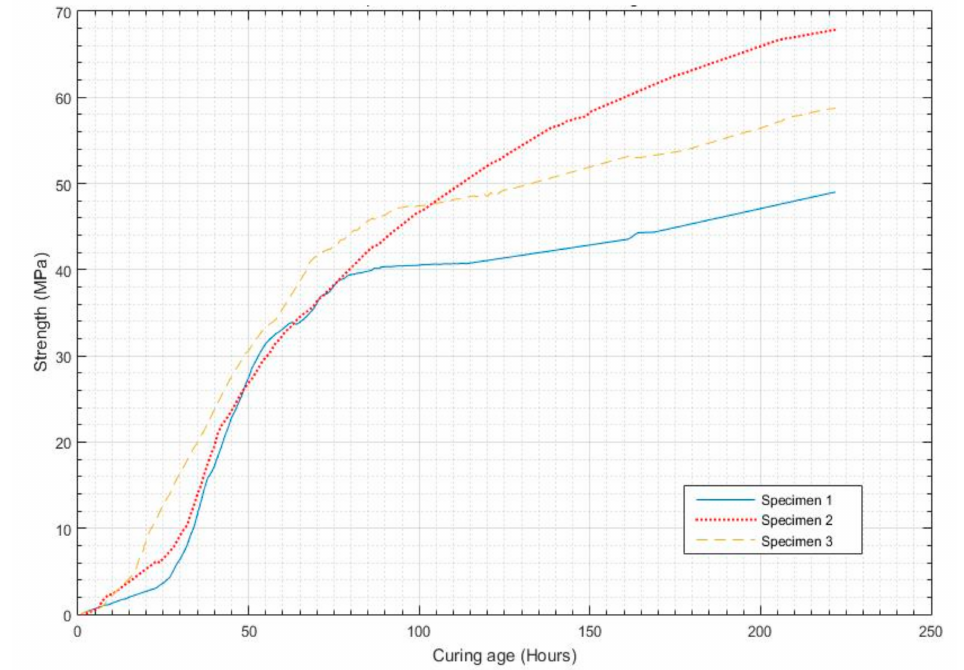
Figure 8. Predicted data for concrete strength development of specimen 1, 2, and